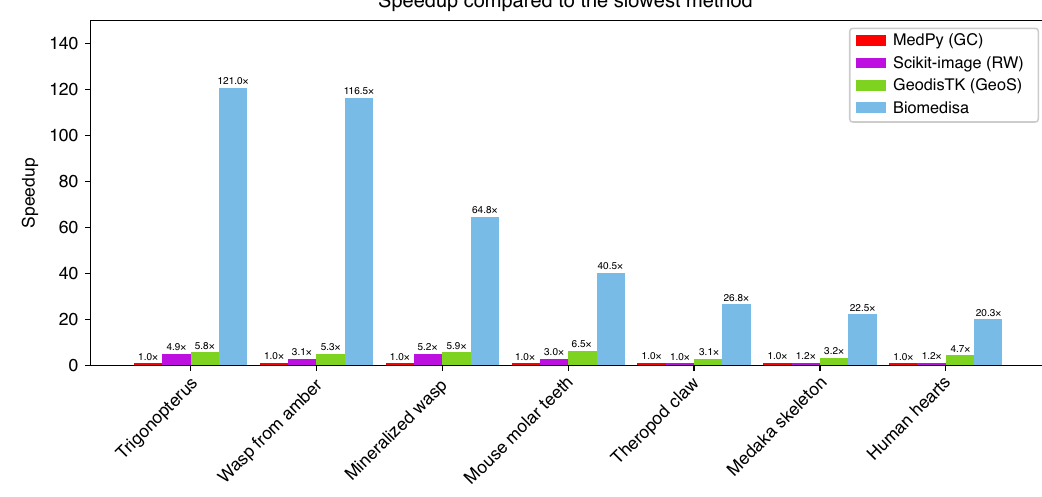
Fig. 6 Speedup of computing times of GPU-based Biomedisa compared to CPU-based segmentation tools. Speedup of computing times of different semi-automatic segmentation tools that take the image data into account compared to the slowest method according to Table 1. The values for mouse molar teeth and human hearts are average